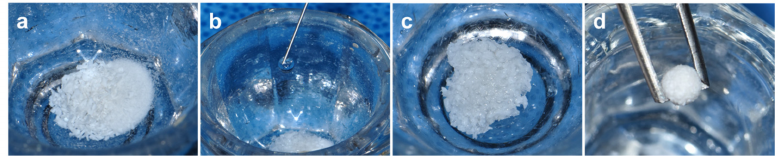
Figure 1. Bone graft material gelation process. ( a ) Prepared 0.25 g of xenograft material, ( b ) added 0.35 cc of saline, ( c ) mixed xenograft material and saline, and ( d ) moldable gelled xenograft material.